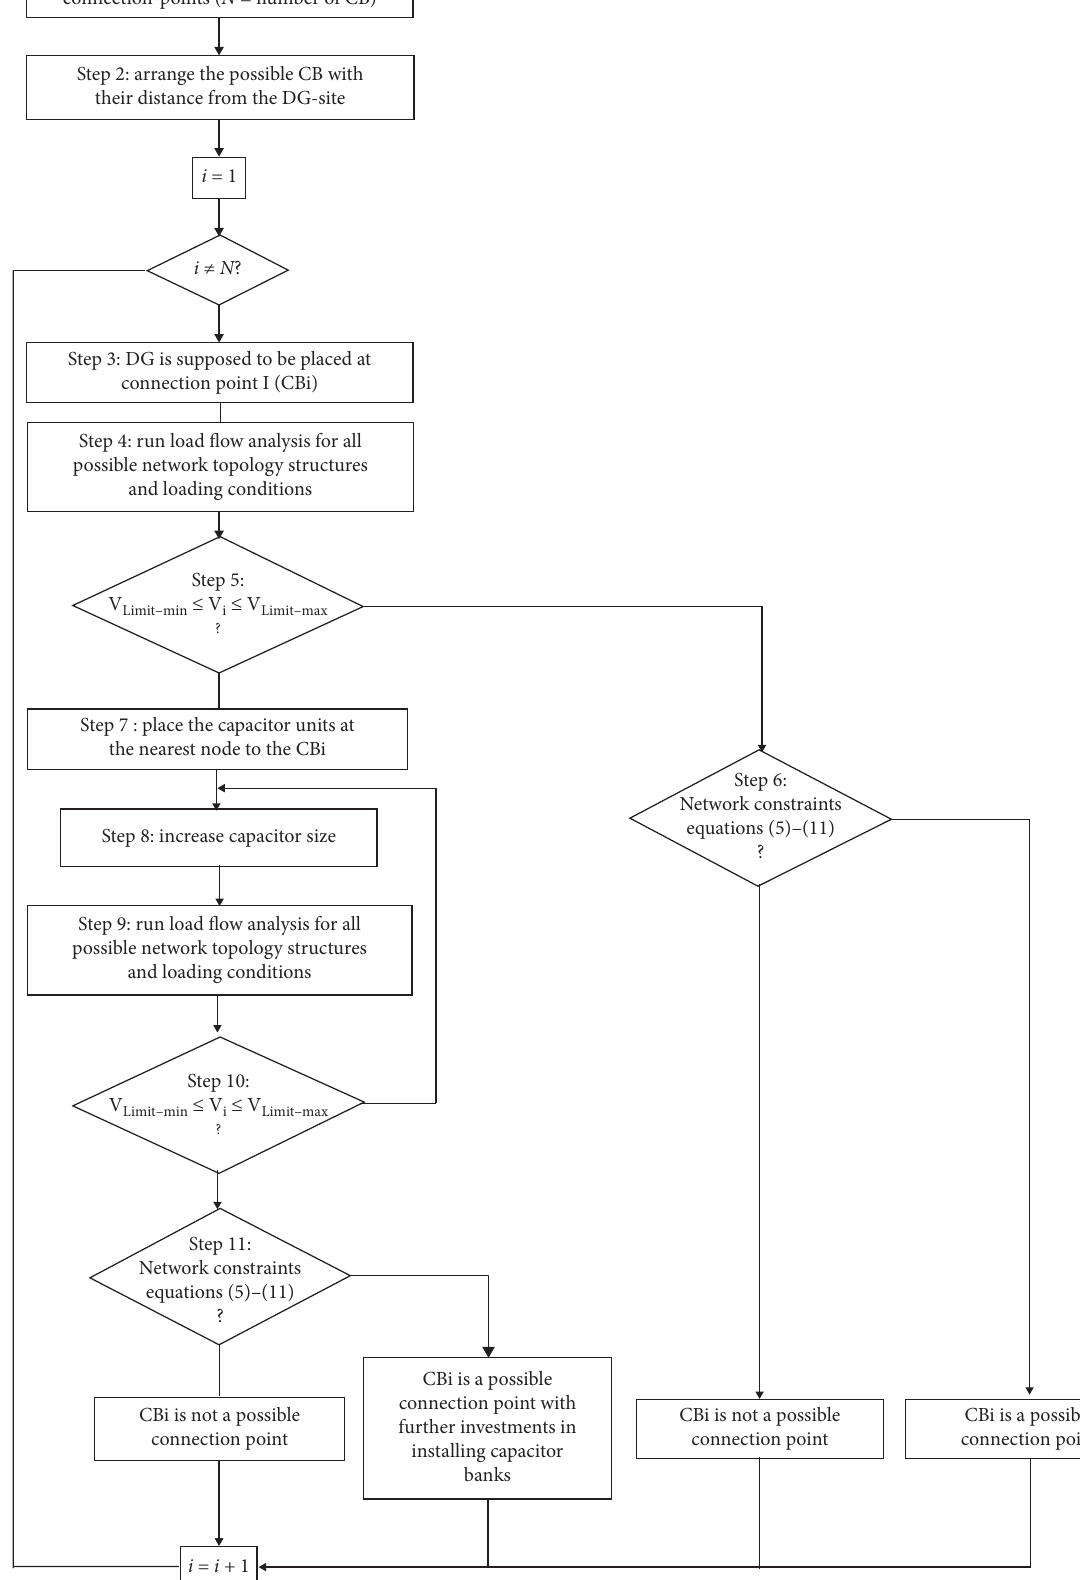
Figure 4: Flow chart of the proposed